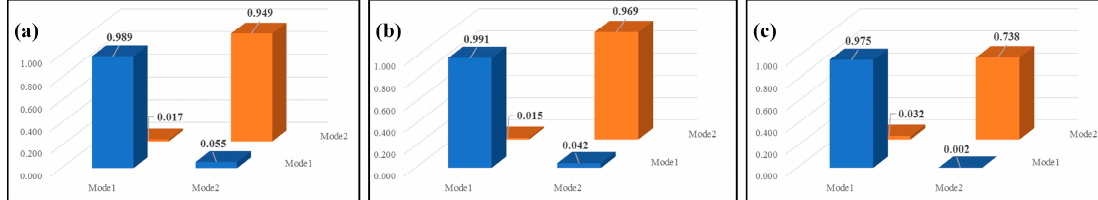
Figure 9. Mode shape comparisons between analytical model and experimental value ( a ) 1st mode shape; ( b ) 2nd mode shape